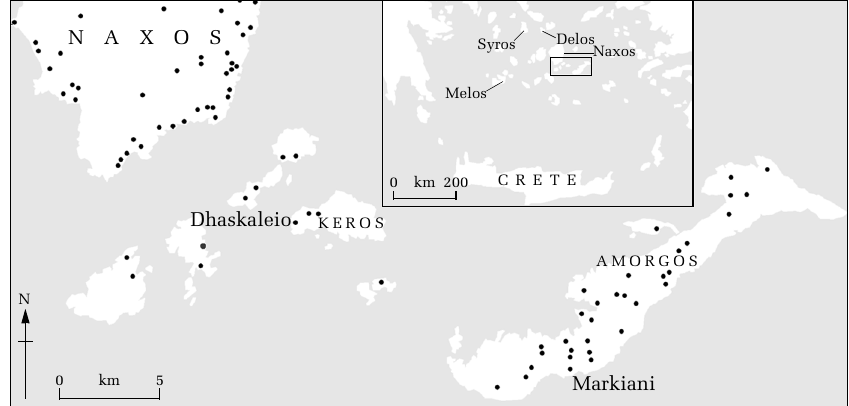
Figure 1 The southern Aegean, showing the location of the islands of Amorgos and Keros in the Cyclades and the distribution of known Early Bronze Age